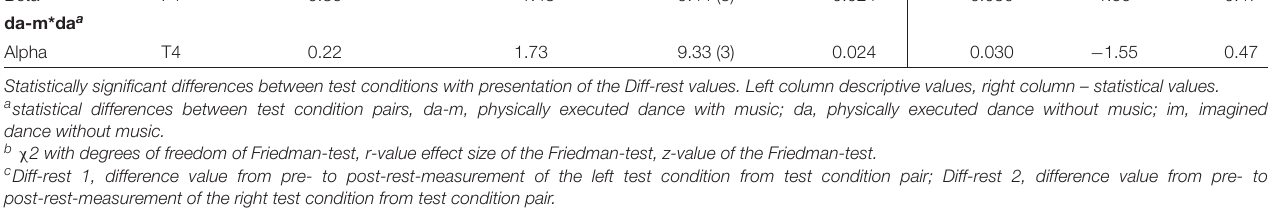
Statistically significant differences between test conditions with presentation of the Diff-rest values. Left column descriptive values, right column – statistical values. a statistical differences between test condition pairs, da-m, physically executed dance with music; da, physically executed dance without music; im, imagined dance without music. b χ 2 with degrees of freedom of Friedman-test, r-value effect size of the Friedman-test, z-value of the Friedman-test. c Diff-rest 1, difference value from pre- to post-rest-measurement of the left test condition from test condition pair; Diff-rest 2, difference value from pre- to post-rest-measurement of the right test condition from test condition